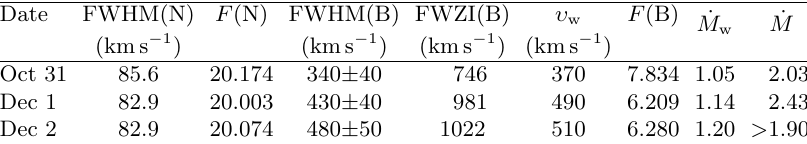
Fig. 3. Left panel. The pro(cid:12)le of the H (cid:13) line on July 9 and October 31. The Gaussian (cid:12)t of the broad component is also shown. The level of the local continuum is marked by a dashed line. Right panel . The pro(cid:12)le of the H (cid:11) and H (cid:13) lines on July 9. The level of the local continuum is marked by a dashed line. Table 2. The H (cid:13) line data. N denotes narrow component and B { broad component. F is in units 10 − 12 erg cm − 2 s − 1 , _ M and _ M w are in units 10 − 7 ( d /1.12 kpc) 3 = 2 M ⊙ yr − 1 , _ M = _ M _ M w + cw